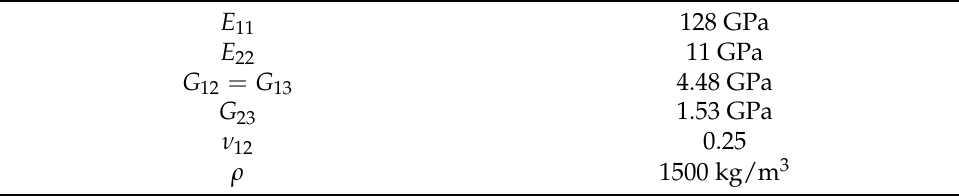
Table 1. Material properties of unidirectional graphite/epoxy laminae